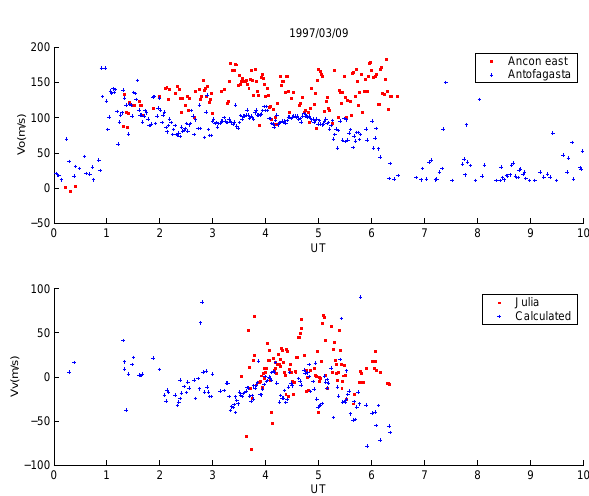
Fig. 8. Geometry at the Ancon-E ionospheric intersection point. Irregularities with horizontal and vertical drift components V h and V v , respectively, yield a calculated V 0 at Ancon-E.